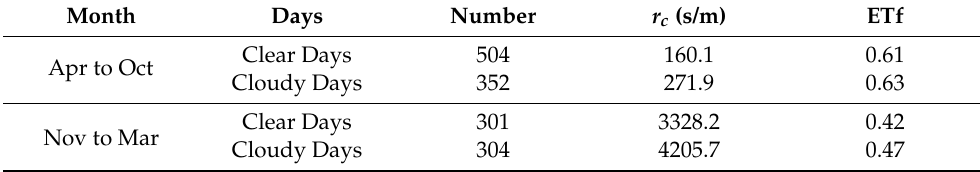
Table 4. The canopy resistance ( r c ) and ETf during the crop growing and non-growing seasons.